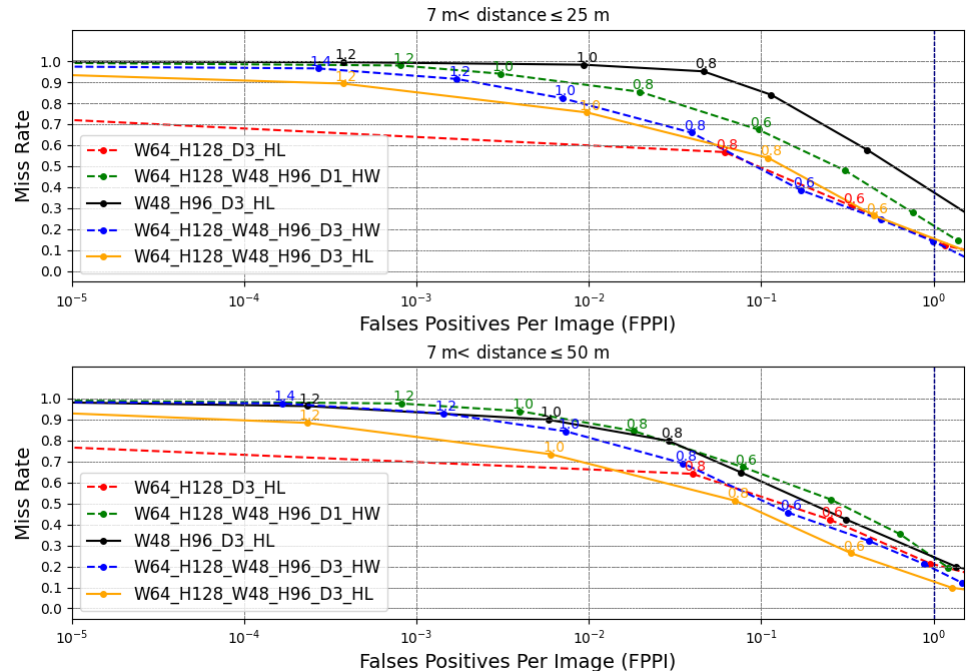
Figure 13. Quality results of some detectors when locating pedestrians, measured by FPPI and MR. The database is split into distance groups. Group 1 and Group 2 refer to pedestrians between 7 and 25 and between 7 and 50 m, respectively. σ SVM values are generated in the interval of [ 2.0,0.0 ] with steps of 0.2 to obtain these results. Each label near the point is the confidence value. The term D is a simplification to D pyr . HL means high-level, stating that the detection function used is from the OpenCV